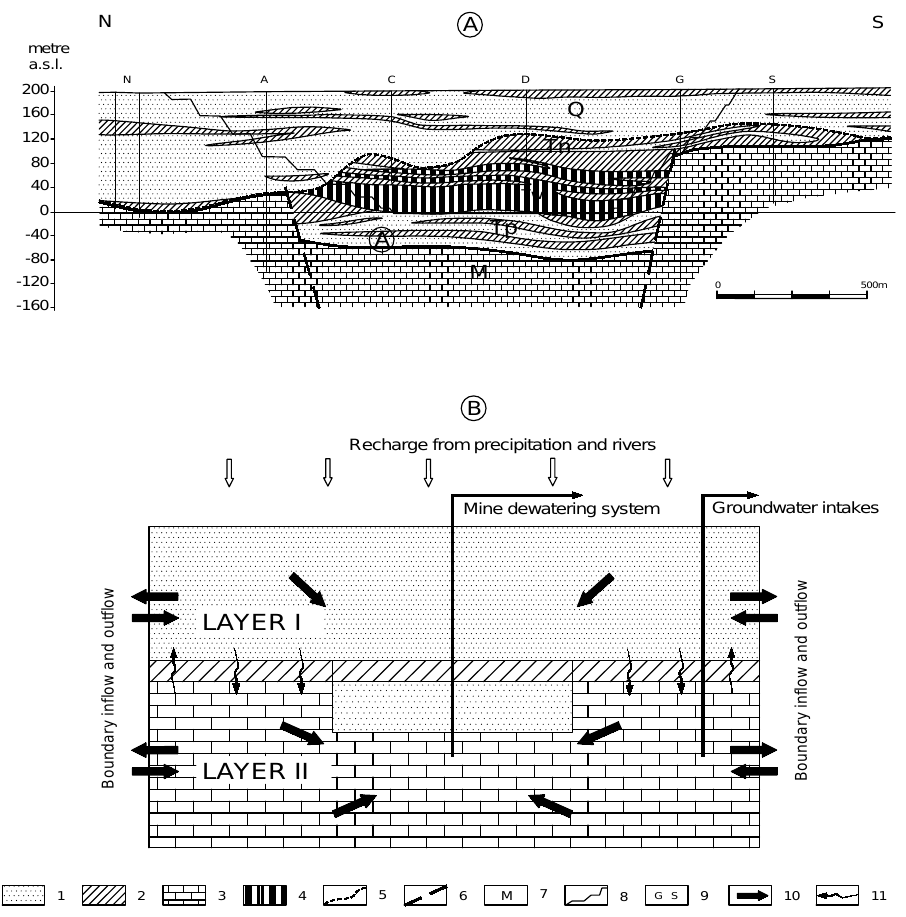
Figure 1. Simplified geological cross-section N-S with the conceptual model suitable for numerical modelling. Explanation: 1 —porous, permeable formations; 2 —impermeable and slightly permeable formations; 3 —fissured-karstic formations; 4 —lignite; 5 —boundary of the Quaternary aquifer; 6 —faults; 7 —symbols of aquifers; 8 —open-pit limits; 9 —dewatering wells barriers; 10 — direction of groundwater flow; 11 —direction of groundwater percolation